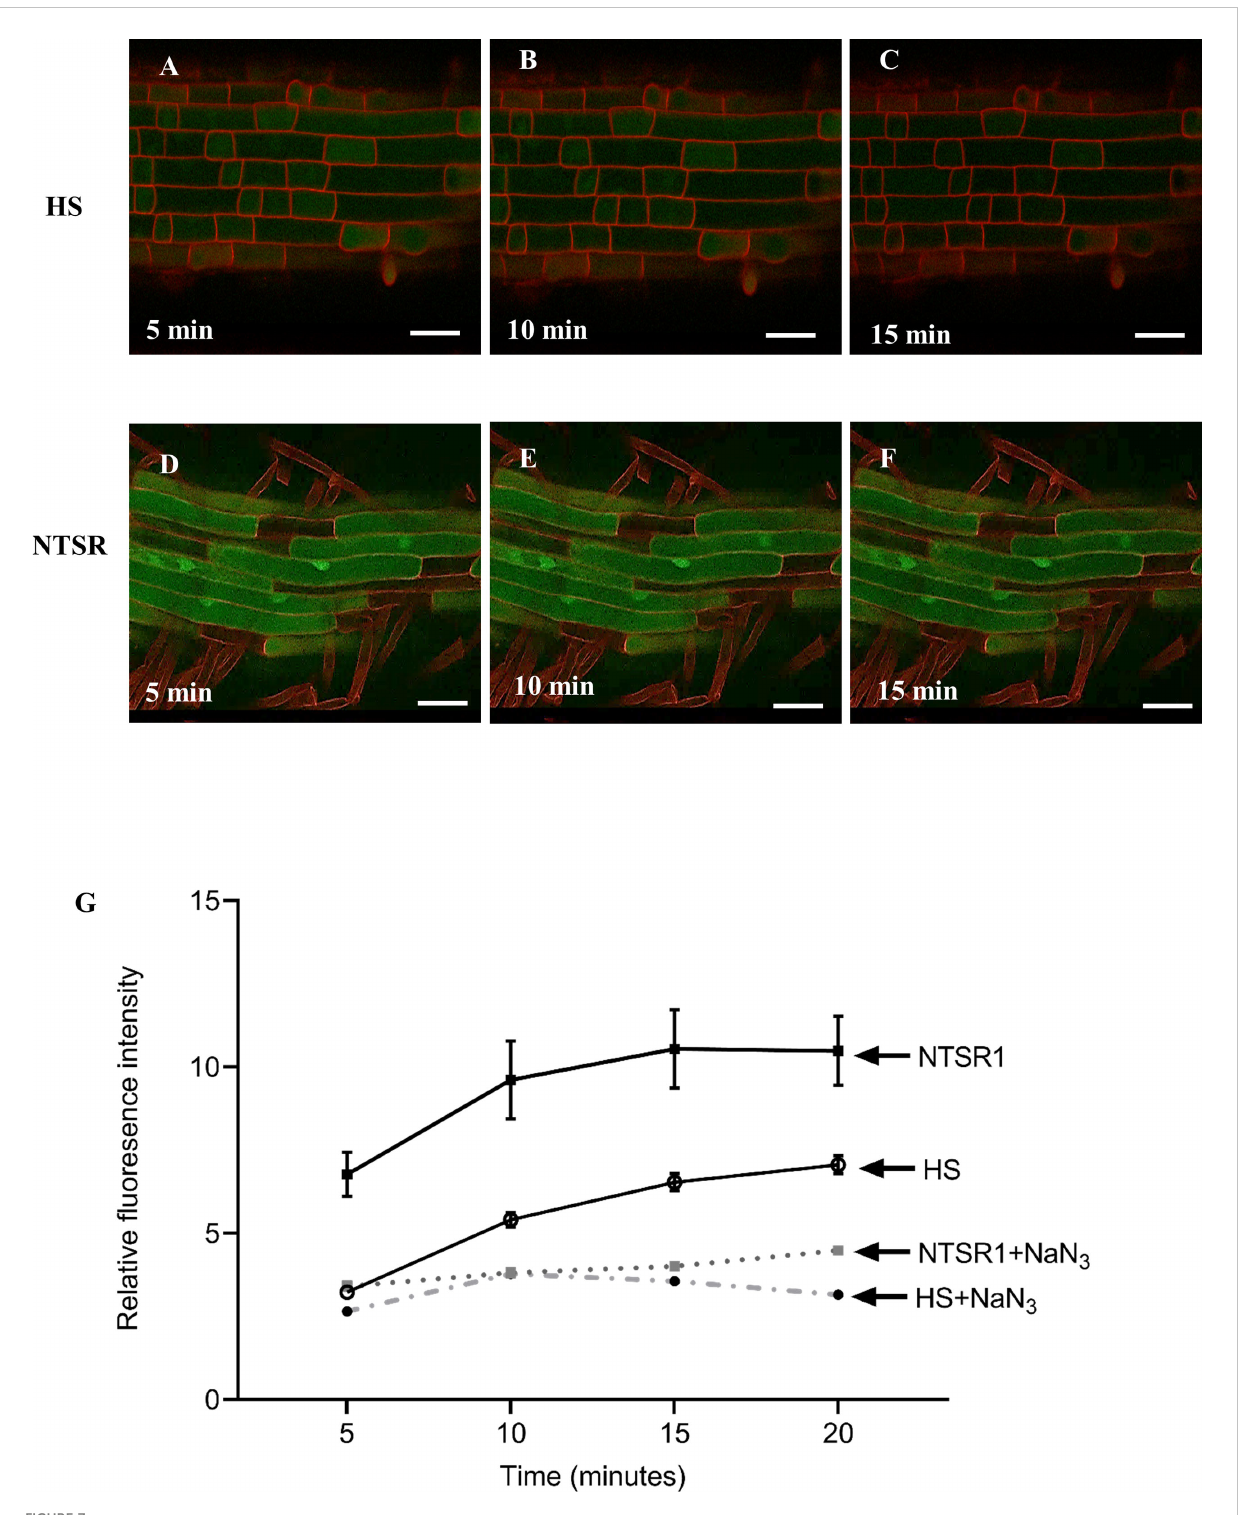
FIGURE 7 Confocal fl uorescent images and intensities derived from NTSR and HS blackgrass roots treated with monochlorobimane (MCB). Confocal images from the roots of HS (A – C) and NTSR (D – F) blackgrass plants, 5, 10 and 15 min after treatment with 100 µM MCB. The fl uorescent intensity of glutathione conjugated bimane (GS-B) was quanti fi ed in 20 individual cells at each time point and plotted as mean ± SD (n=20) of fl uorescence intensity at each time point (G) for NTSR and HS blackgrass